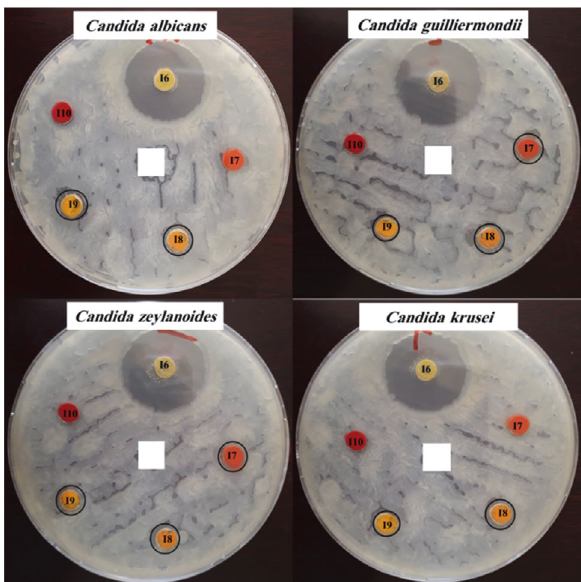
Figure 4. Activity against Candida yeasts of the prepared tetrazole derivatives I 6 – I